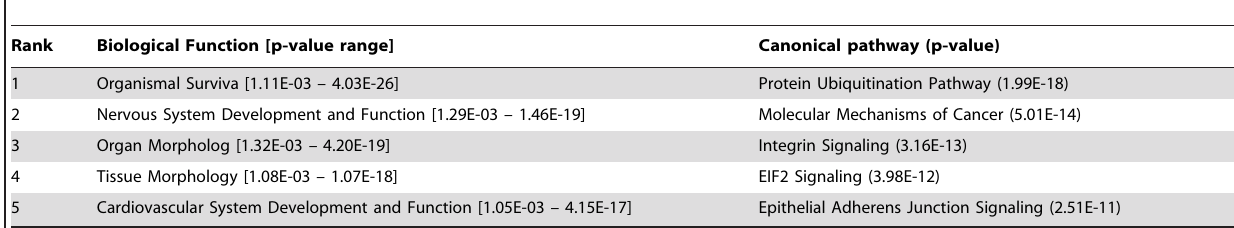
Table 3. Functional enrichment of the mouse genes mapped by our transcriptome assembly.